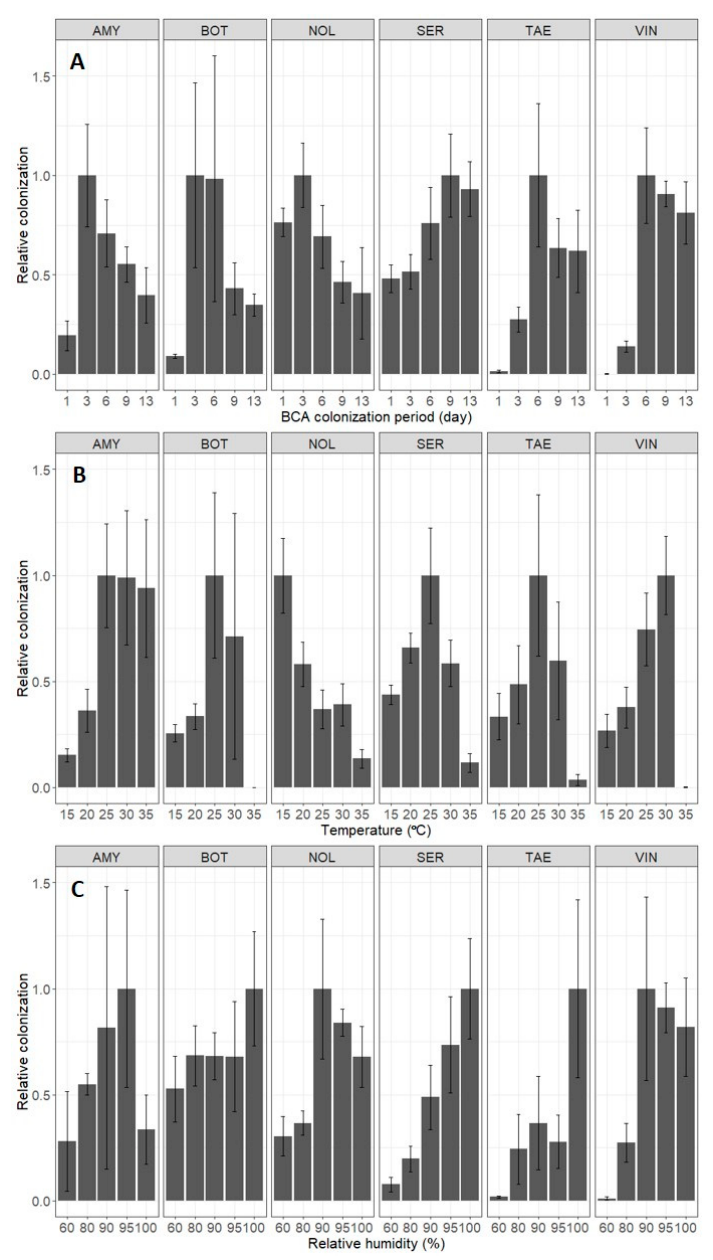
Figure 3. Relative colonization on bunch trash by the six BCAs as affected by ( A ) the length of the colonization period (in days), and by ( B ) the temperature and ( C ) relative humidity level that the bunch trash was subjected to after the BCA treatment. Bars are overall means of different T/RH regimes in ( A ) and of different numbers of days after the BCA treatment in ( B ) and ( C ); whiskers show standard error.